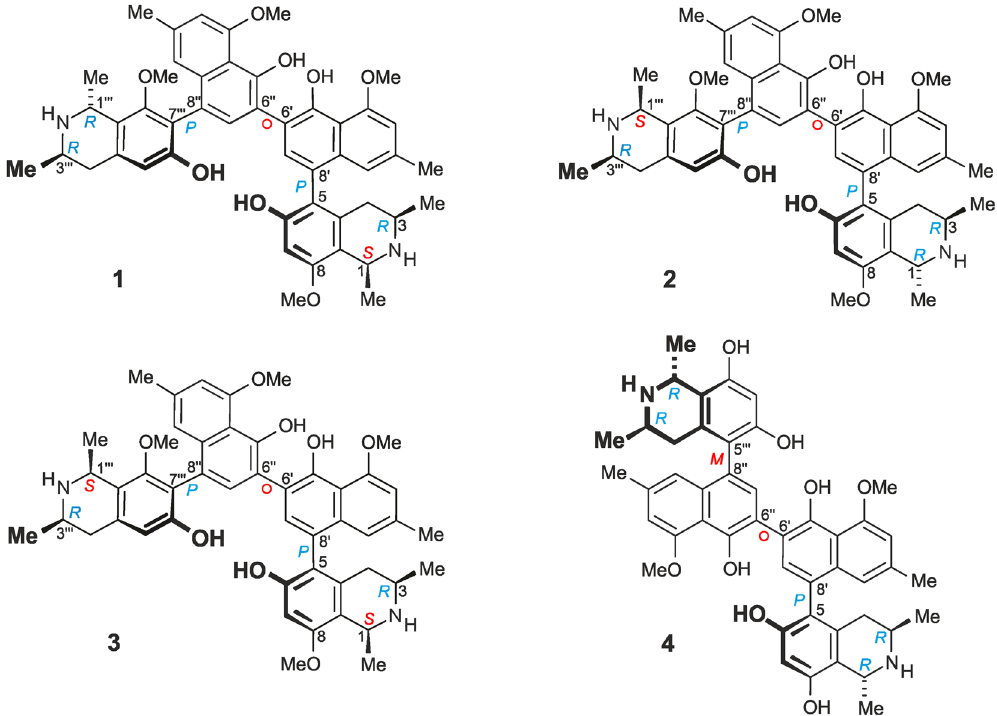
Figure 1. Ealapasamines (A–C) ( 1 – 3 ) from A. ealaensis , and michellamine (B) ( 4 ) from A. korupensis